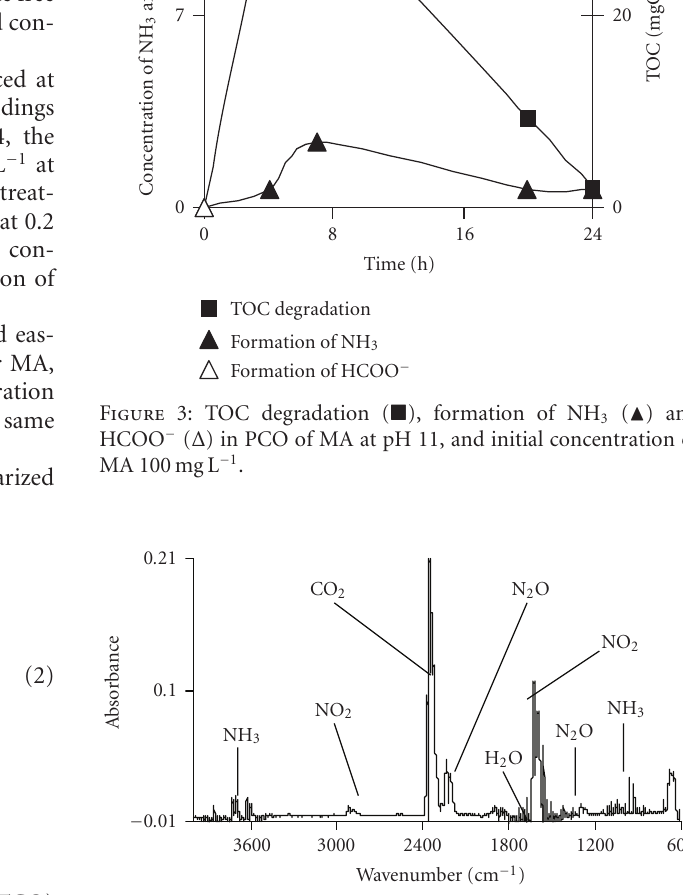
Figure 4: FT-IR spectrum of the outlet flow containing PCO prod- ucts of